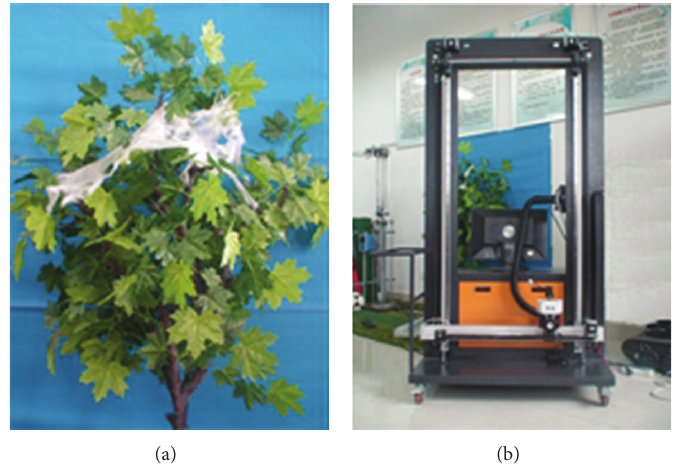
Figure 9: The simulation tree (a) and experimental prototype